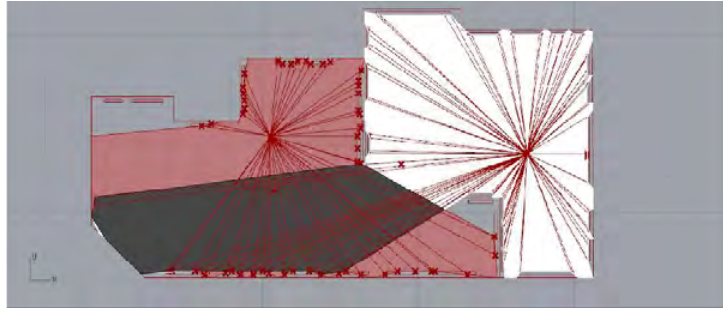
Figure 6. The intersection of two different visitors from Decoding Spaces component In another position